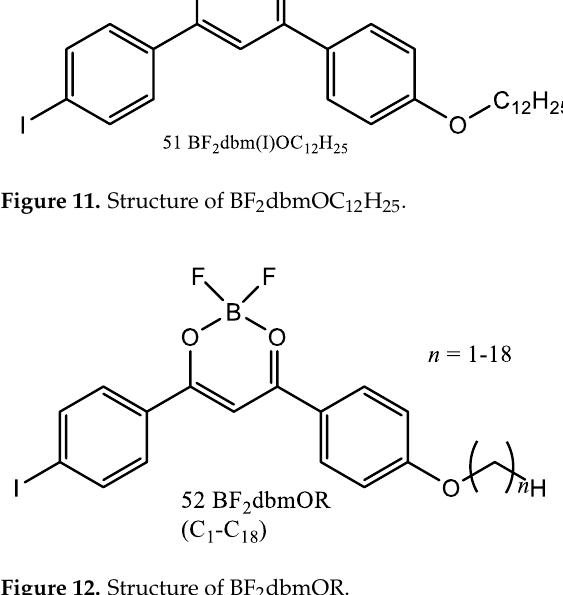
Figure 13. ( A ) Chemical structure of BF 2 AVB. ( B – D ) Photos showing ( B ) green and ( C ) cyan crys- tals, and ( D ) the blue coral-like solid under UV excitation ( λ ex) 365 nm). ( E ) SEM image of the dendritic coral-like structure. ( F ) Magnified view of the porous surface.